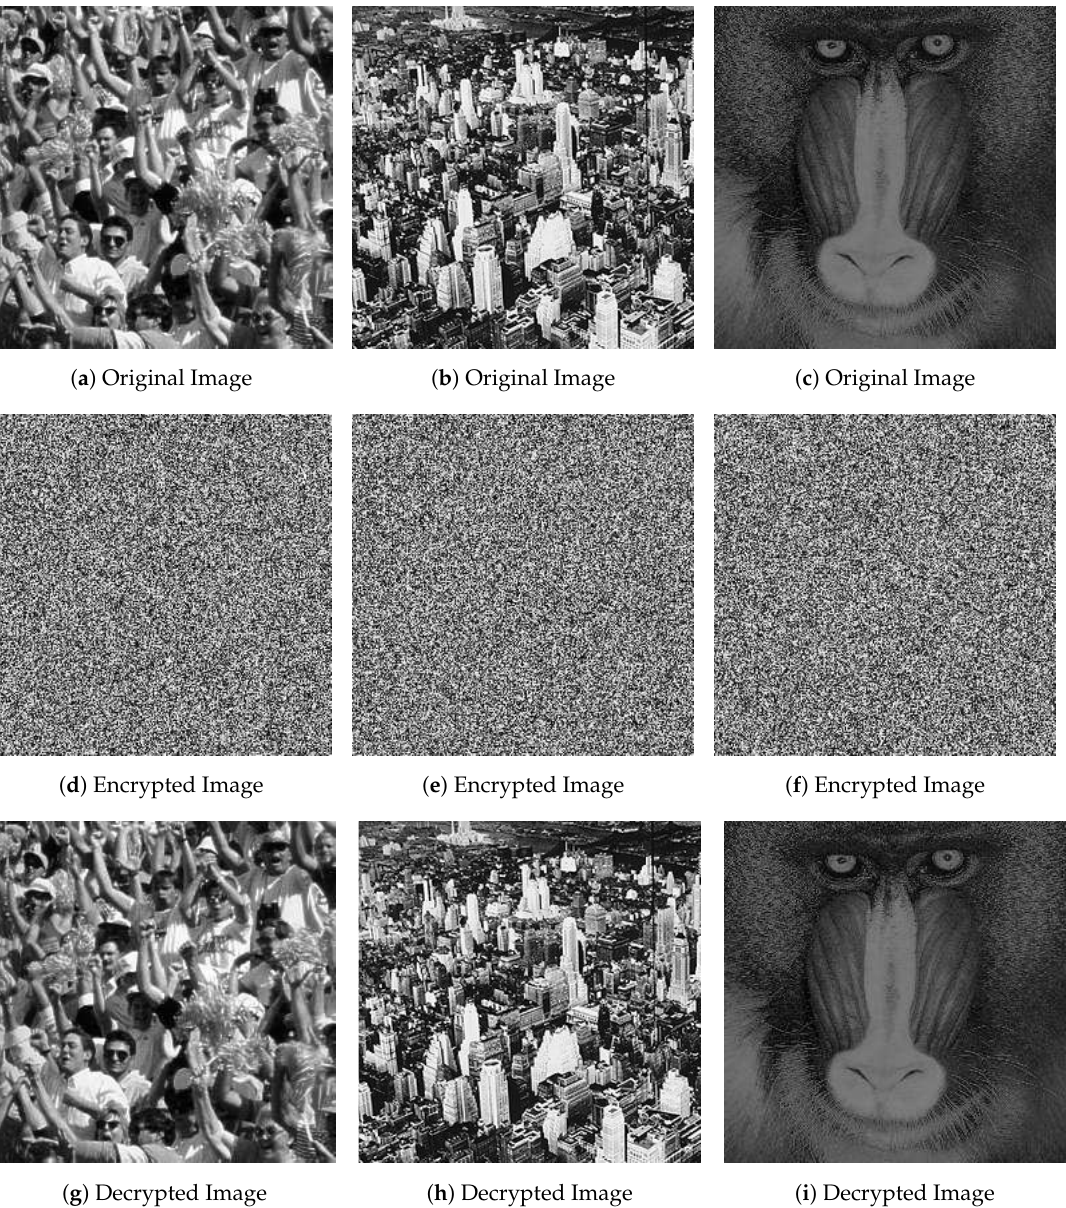
Figure 7. The result of image encryption. ( a ) original fan image, ( b ) original city image , ( c ) original baboon image, ( d ) encrypted fan image, ( e ) encrypted city image , ( f ) encrypted baboon image, ( g ) decrypted fan image, ( h ) decrypted city image , ( i ) decrypted baboon